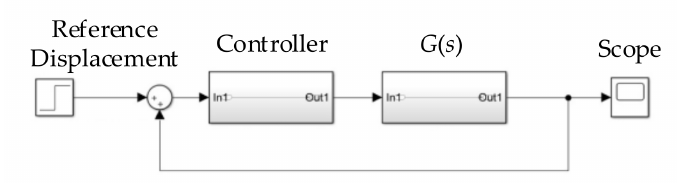
Figure 14. Control block diagram.